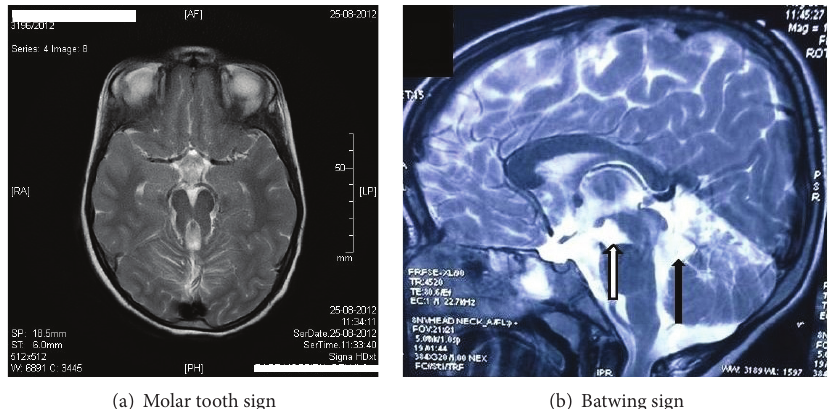
Figure 1: (a) shows thinning of the isthmus with hypoplastic superior cerebellar peduncles forming typical “molar tooth appearance.” (b) Hypoplasia of vermis with resultant “batwing appearance” in the fourth